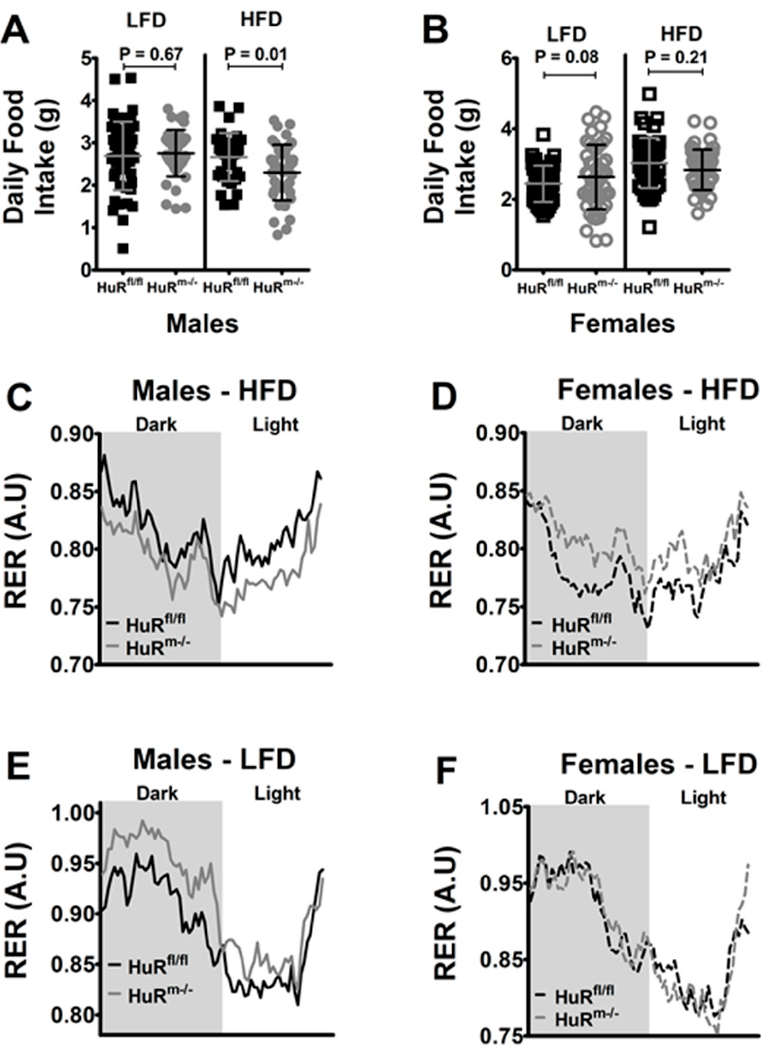
Figure 2. Male but not female HuR m − / − mice display decreased food intake as dietary fat increases. ( A ) Average daily food intake is shown for male control (black) and HuR m − / − (grey) mice fed LFD or HFD ( n = 36–48). ( B ) Average daily food intake is shown for female control (black) and HuR m − / − (grey) mice fed LFD or HFD ( n = 48). ( C ) Average RER is shown for dark and light cycles for male control (black) and HuR m − / − (grey) mice fed HFD ( n = 12–14). ( D ) Average RER is shown for dark and light cycles for female control (black) and HuR m − / − (grey) mice fed HFD ( n = 16). ( E ) Average RER is shown for dark and light cycles for male control (black) and HuR m − / − (grey) mice fed LFD ( n = 14–16). ( F ) Average RER is shown for dark and light cycles for female control (black) and HuR m − / − (grey) mice fed LFD ( n = 16).